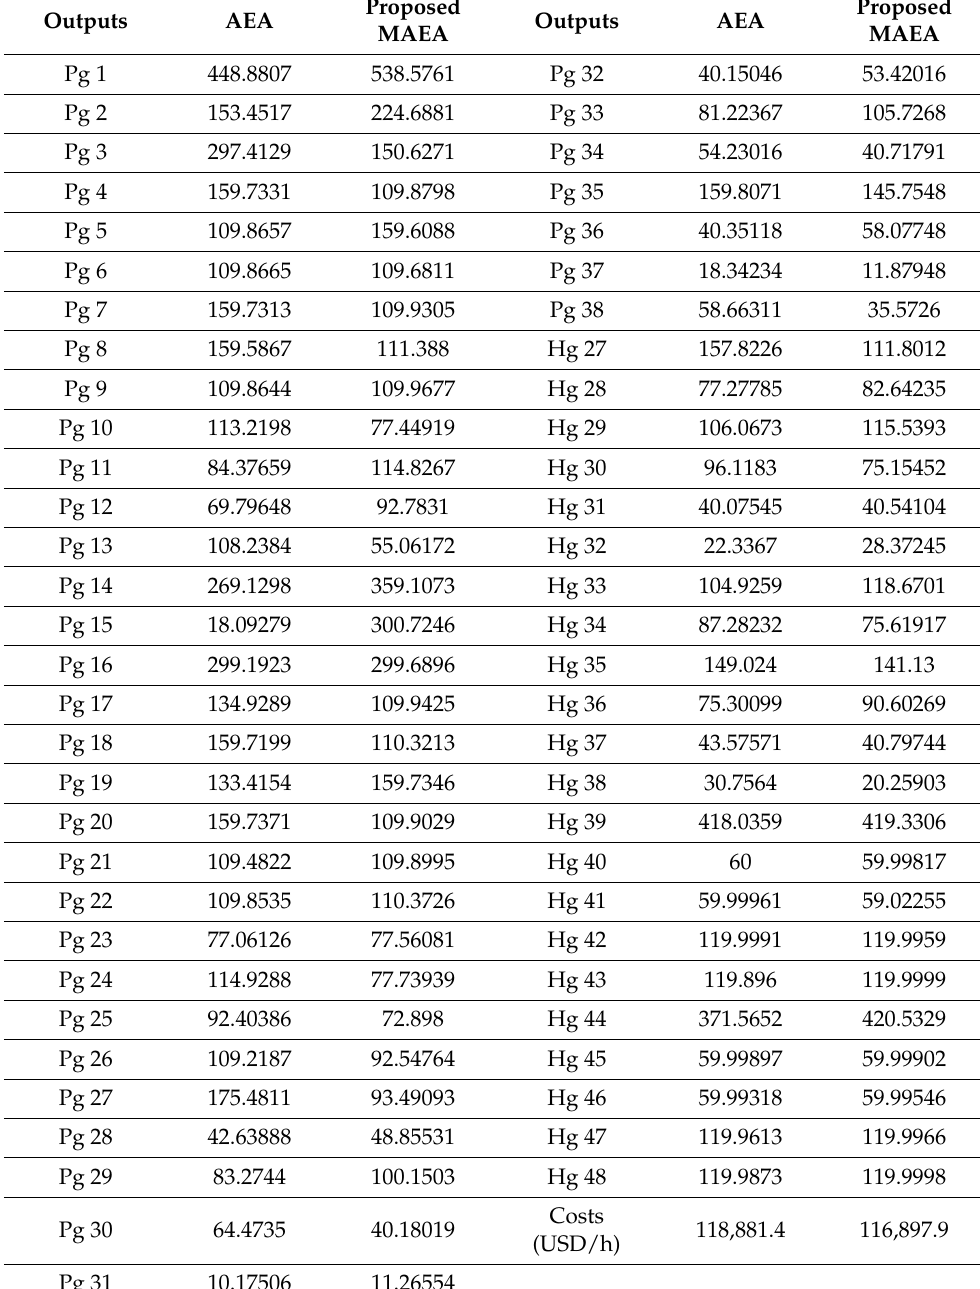
Table 6. Optimal operational settings and related costs of the proposed MAEA and the basic AEA of Case